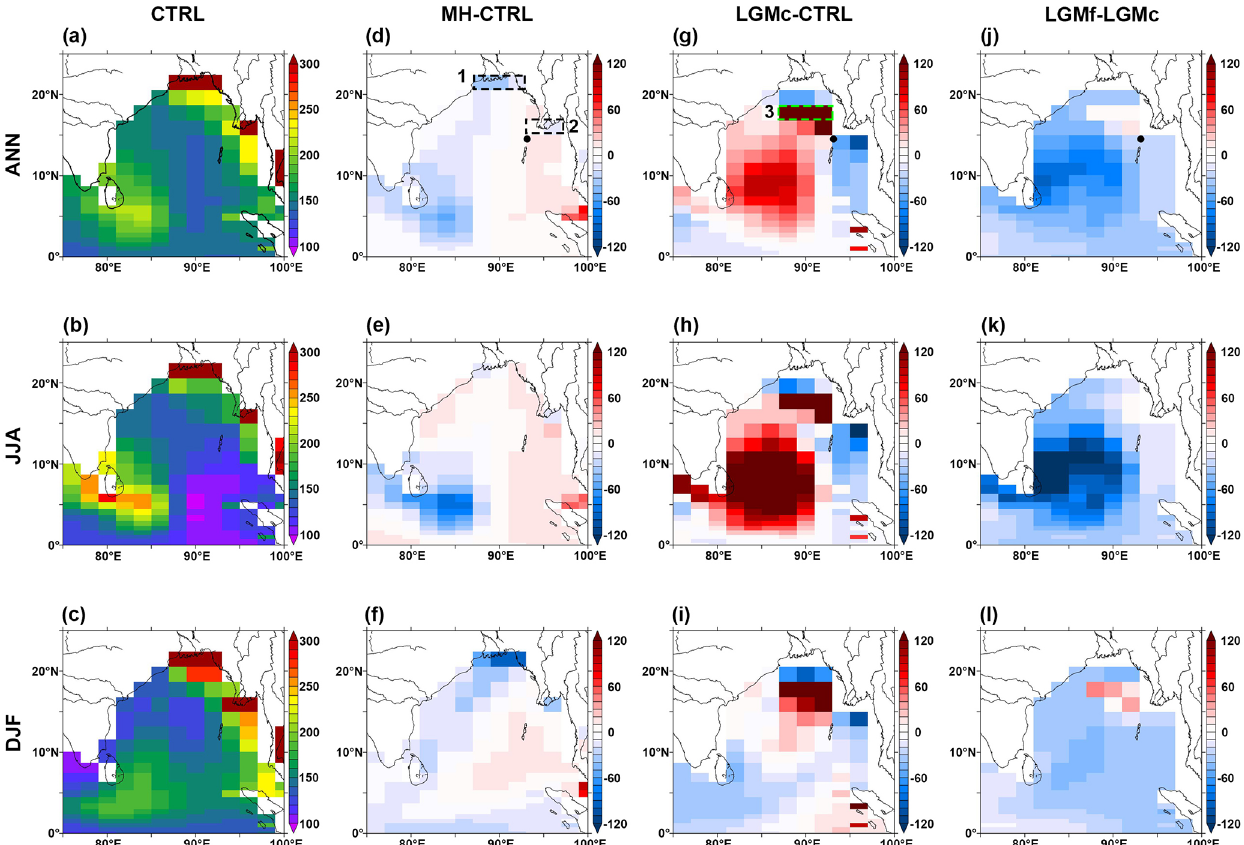
Figure 3. IPSL-CM5A-LR-simulated integrated PP of the full water column (gCm − 2 yr − 1 ) for the pre-industrial (CTRL) (a–c) . PP dif- ferences between the mid-Holocene (MH) and CTRL (d–f) , the Last Glacial Maximum (LGMc) and CTRL (g–i) , and the Last Glacial Maximum under AMOC shutdown (LGMf) and LGMc (j–l) . Results are shown for annual mean (ANN), summer (June–July–August, JJA), and winter (December–January–February, DJF). Rectangles 1 and 2 in panel (d) mark the grids from which the vertical profiles in Fig. 4 are extracted. Rectangle 3 in panel (e) marks the grids from which the vertical profiles in Fig. 5 are extracted. The black dots mark the location of core